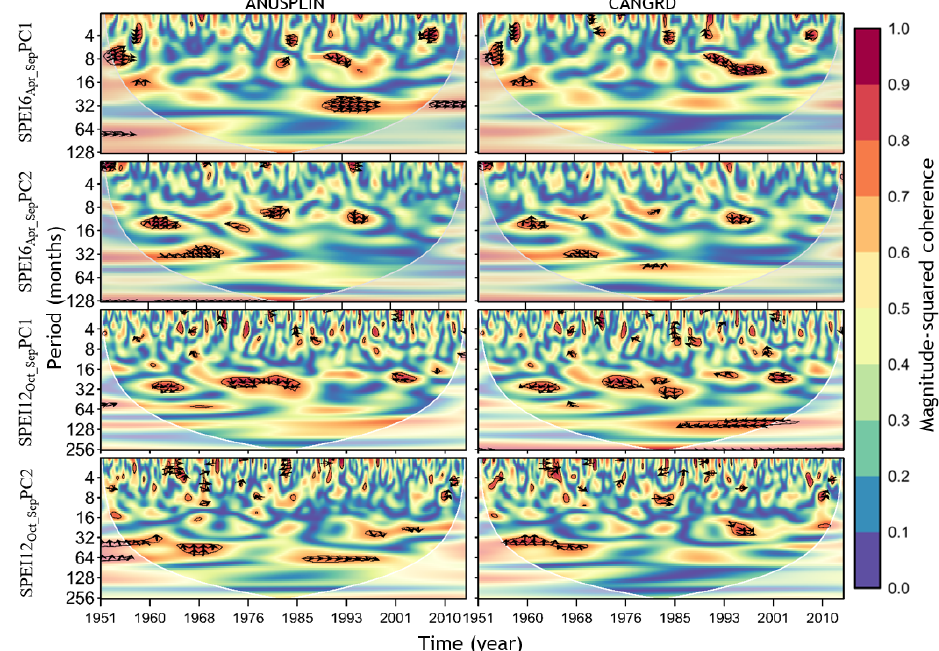
Figure 10. Squared wavelet coherence between the PDO and the temporal patterns of drought (SPEI6 Apr − Sep and SPEI12 Oct − Sep ) . Phase arrows pointing right indicate signals are in phase, whereas left-pointing arrows indicate an antiphase relationship. Arrows deviating from the horizontal are indicative of lead–lag relationships between the two signals. The black contour designates the 95% confidence level against red noise, and the cone of influence (COI), where edge effects might distort the picture, is shown as a lighter grey shade.